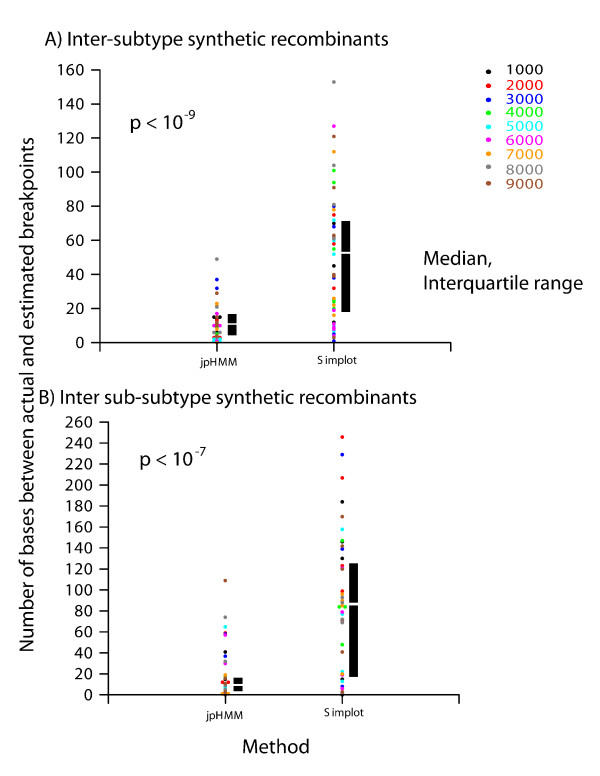
Evaluation of breakpoints predicted by jpHMM and Simplot. We measured the distance between the predicted breakpoints and the real breakpoints as described in the literature. For these distances, we calculated the median value and the interquartile range. A) Inter-subtype artificial recombinants: jpHMM's median is 10, with the interquartile range of 4–15; Simplot's median is 54, with the interquartile range of 19–72 and p <10-9 in the Wilcoxon signed-rank test. B) Inter sub-subtype artificial recombinants: jpHMM's median values 9, interquartile ranges 3.5–19; Simplot's median values 84, interquartile ranges 19.5–122 and p <10-7 in the Wilcoxon signed-rank test. In both plots (A and B), the Y -axis represents the number of bases that predicted breakpoints were away from the actual ones. The median values are shown here as the white bars, and the interquartile ranges are shown as the black bars. Numbers in color represent the actual breakpoint positions (every 1000-th nucleotide) in all synthetic recombinants. The duplicated data positions were spread apart in order to show every individual breakpoint here.